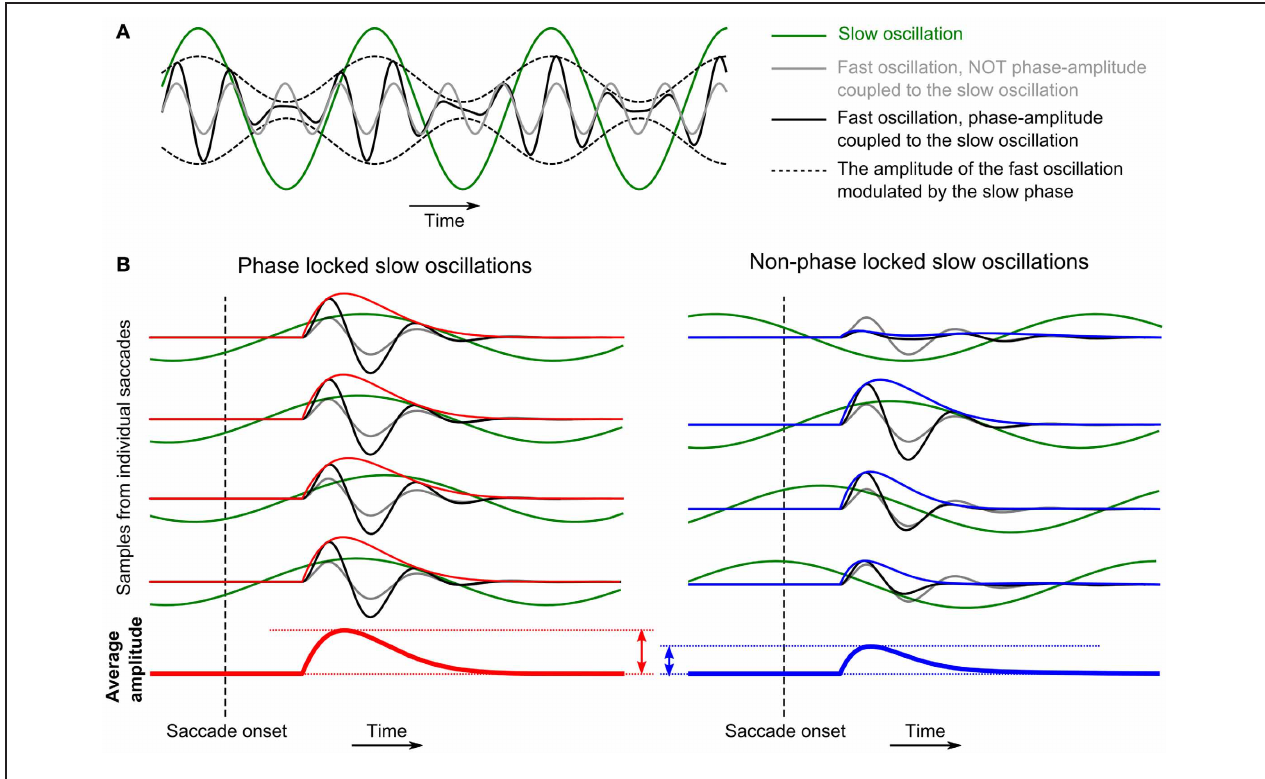
(B) Schematic representing how PAC causes correlation between phase-locking of the delta-theta band oscillations to the timing of EMs and the average power in the alpha-beta or the low-gamma band evoked by the